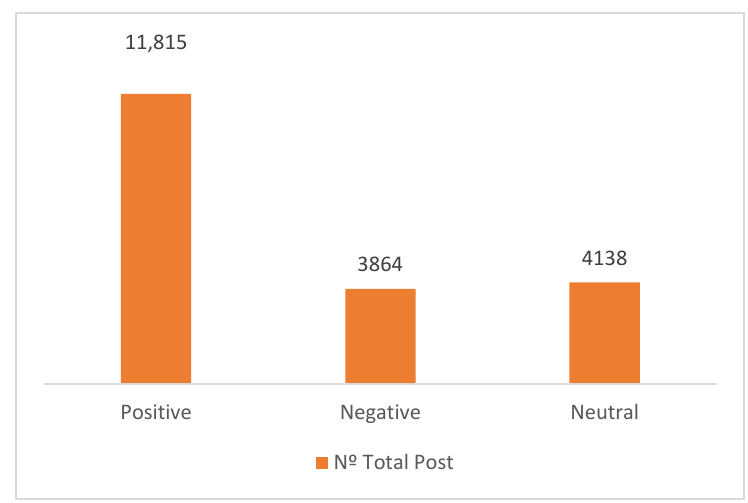
Figure 4. Number of posts by sentiment type.